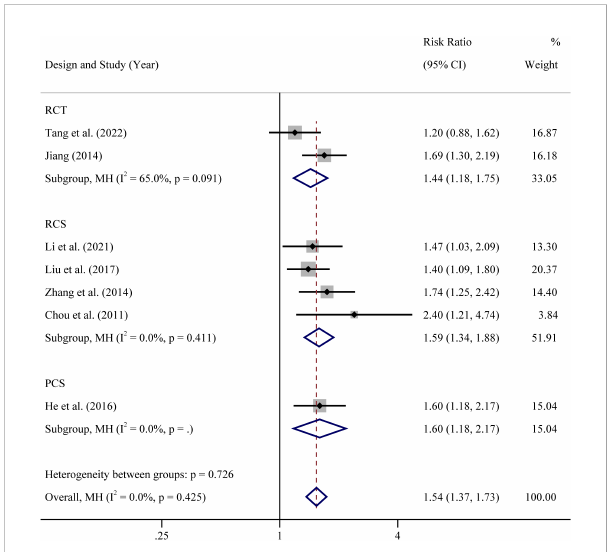
FIGURE 3 Subgroup analysis based on study design of clinical pregnancy rate RCT: In view of the different designs of the included studies, RCS: In view of the different designs of the included studies, PCS: In view of the different designs of the included